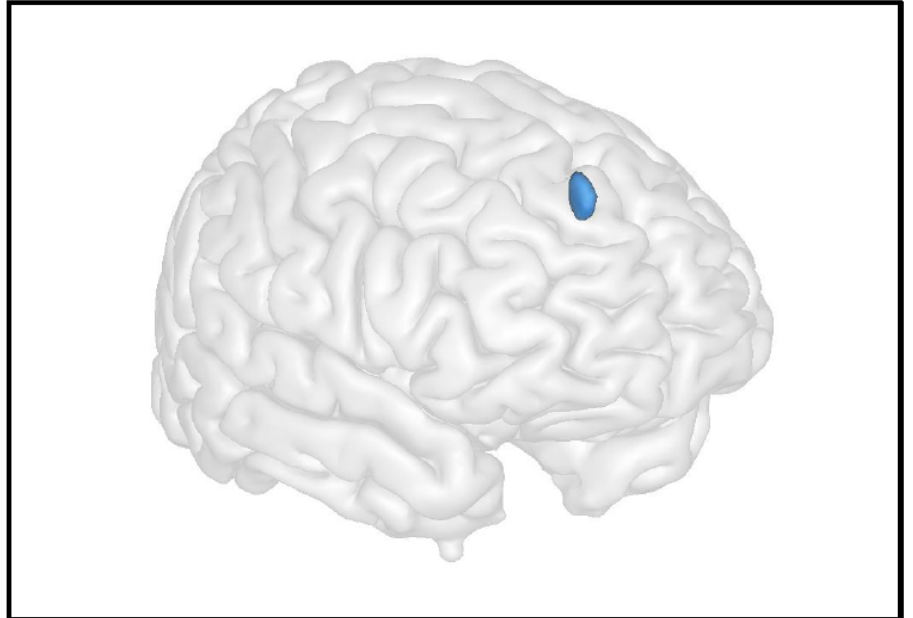
Figure 4. Advanced neuroimaging techniques can help in understanding the impact of cystinosis on the brain’s anatomo-function and its link with neurocognitive impairments. For instance, here, we illustrate the results of Scheme 10 (y = 50 z = 40), a brain region strongly implicated in cognitive functions: the higher the cystine levels, the lower the resting CBF in this area, which is associated with cognitive functions. Maximum intensity projections of T statistics clusters that are significantly correlated with individual cystine blood level are superimposed on a 3D volume rendering on grey matter in the MNI space.